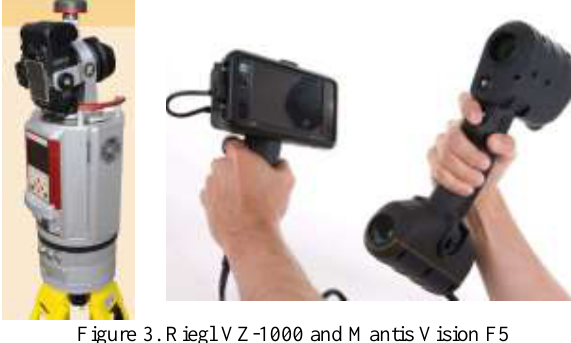
Figure 3. Riegl VZ-1000 and Mantis Vision F5 (www.mantisvision.com)